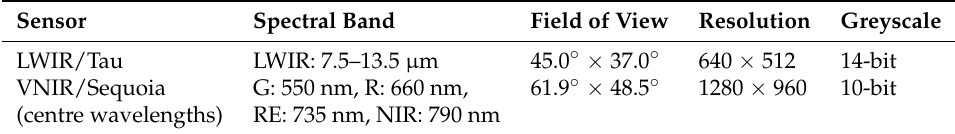
Table 1. Details of the thermal camera (uncooled microbolometer, thermal resolution: 0.04K) and the multispectral sensor used. According to the spatial resolution of the sensors, the pixel size (px) for VNIR at a height of about 80 meters is about 7 cm/px and for LWIR 10 cm/px. Sensor Spectral Band Field of View Resolution Greyscale LWIR/Tau LWIR: 7.5–13.5 µ m 14-bit VNIR/Sequoia G: 550 nm, R: 660 nm, (centre wavelengths) RE: 735 nm, NIR: 790